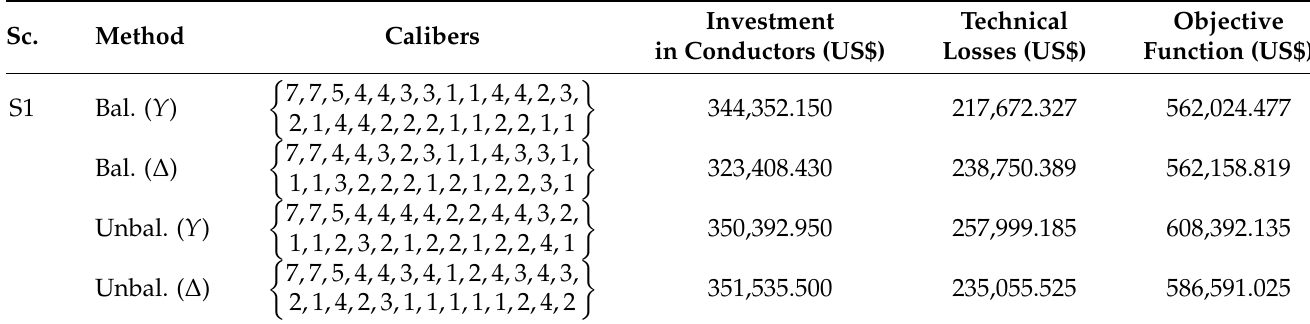
Table 26. Comparative analysis for the 27-bus system with loads with ∆ - and Y -connections.